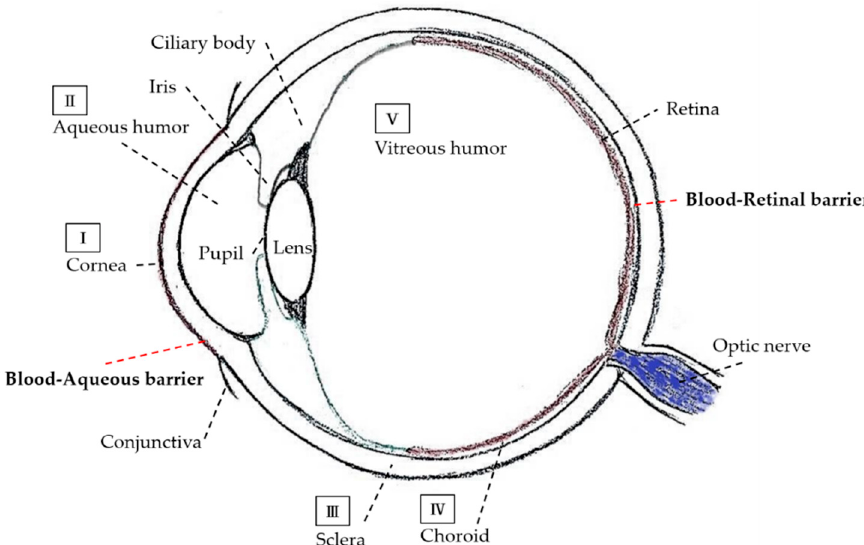
Figure 1. Schematic diagram of the ocular structure with various ocular barriers. The ocular barriers in the anterior segment area ( I ) tear film and corneal epithelium, and ( II ) aqueous humor. The ocular barriers in the posterior segment are ( III ) sclera, ( IV ) choroid, and ( V ) vitreous humor. There are two BRBs. The blood–aqueous barrier in the anterior segment, a part composed of the non-pigmented ciliary epithelial cells and iris capillaries endothelial cells. The BRB, a tight-junction between non-fenestrated capillaries of the retinal blood circulation and retinal pigment epithelial cells in the posterior segment of the eye.